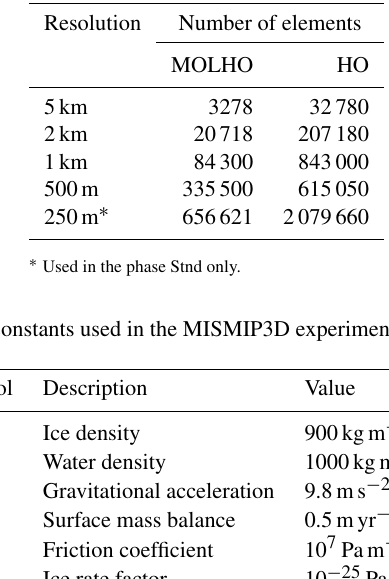
Table 2. Mesh resolutions and the associated number of elements used in the MISMIP3D experiment.